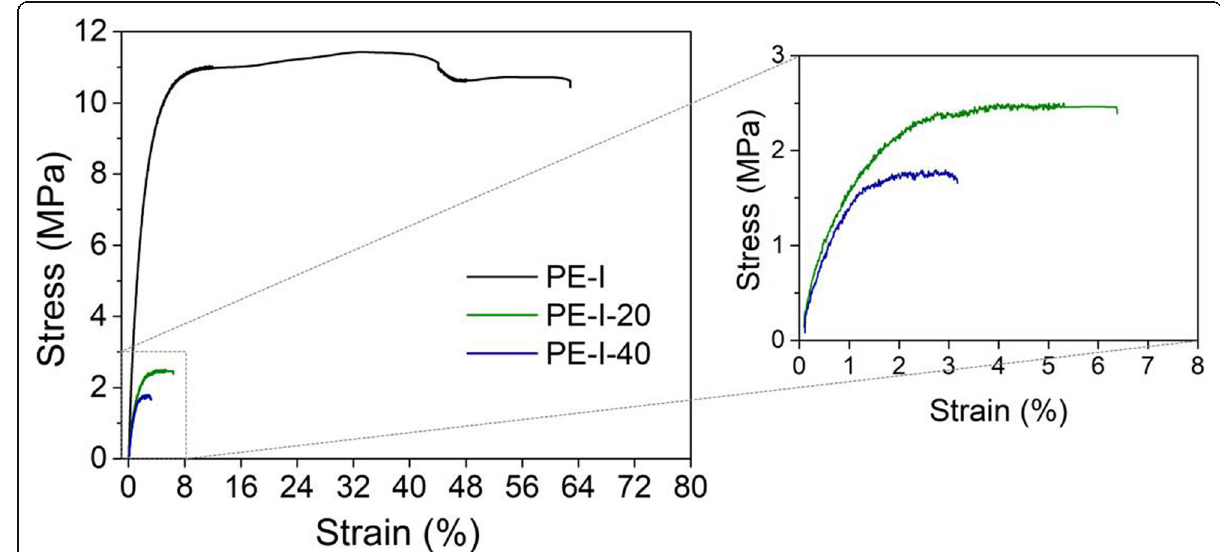
Fig. 6 Stress vs. deformation curves of pure PE-I, and PE-I-20 and PE-I-40